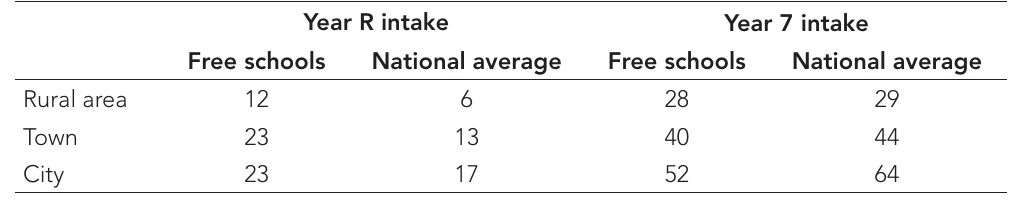
Table 2: Number of LSOAs from which free schools